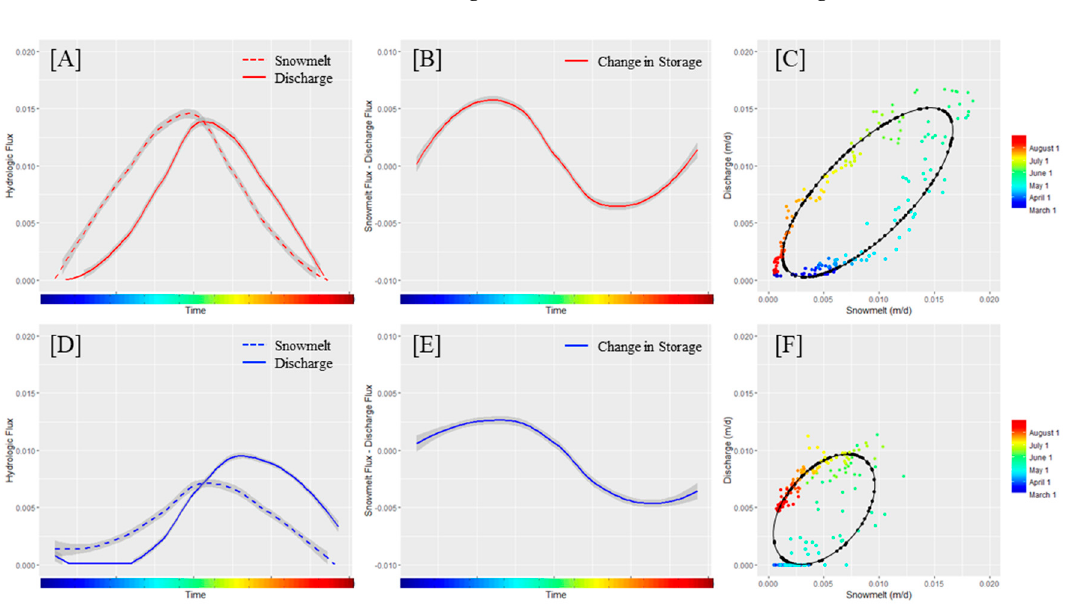
Figure 7. Study catchment data using average daily data for the study period for ELW ( A – C ) and GL4 ( D – F ). Plots A and D show the smoothed time series of the mean daily snowmelt and the mean daily discharge flux data with a 95% confidence interval shown in dark grey. Plots B and E show the mean daily snowmelt flux minus the mean daily discharge flux, or the change in storage over time. Plots C and F show mean daily snowmelt versus mean daily discharge over time, and the fitted event-response ellipse.